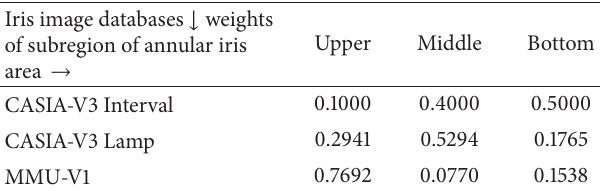
Table 2: Weighted coefficients assignment on subregion for three